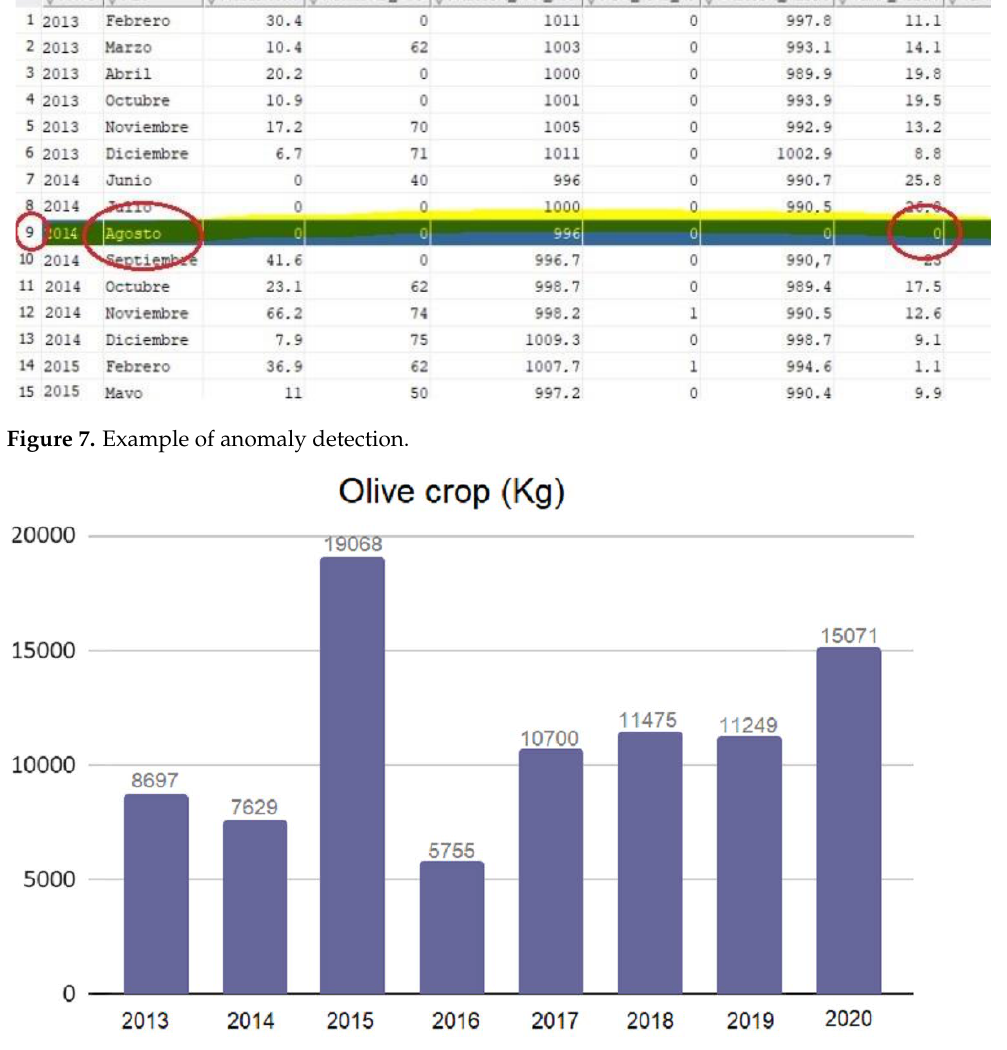
Figure 8. Yield data history of the farm under study.